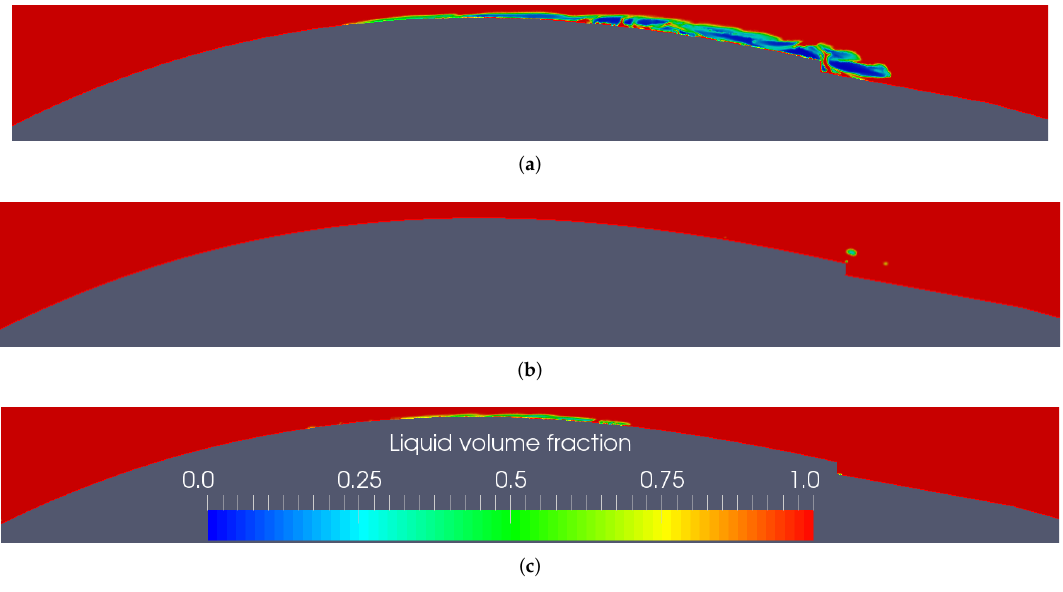
Figure 5. Liquid volume fraction for ( a ) no injection (case AOA3b), ( b ) mild injection (case AOA3c) and ( c ) high injection (case AOA3d). Only the truncated suction side of the hydrofoil is shown.